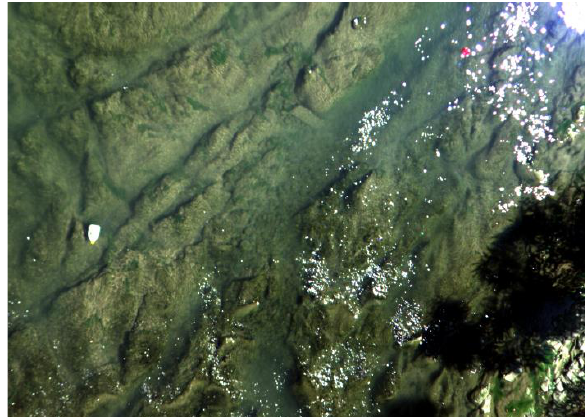
Figure 1. Example of multi-spectral image in the considered dataset. Red, Green and Blue (RGB) colours of the image are displayed in the figure. It is possible notice the sunglint effects on the sea